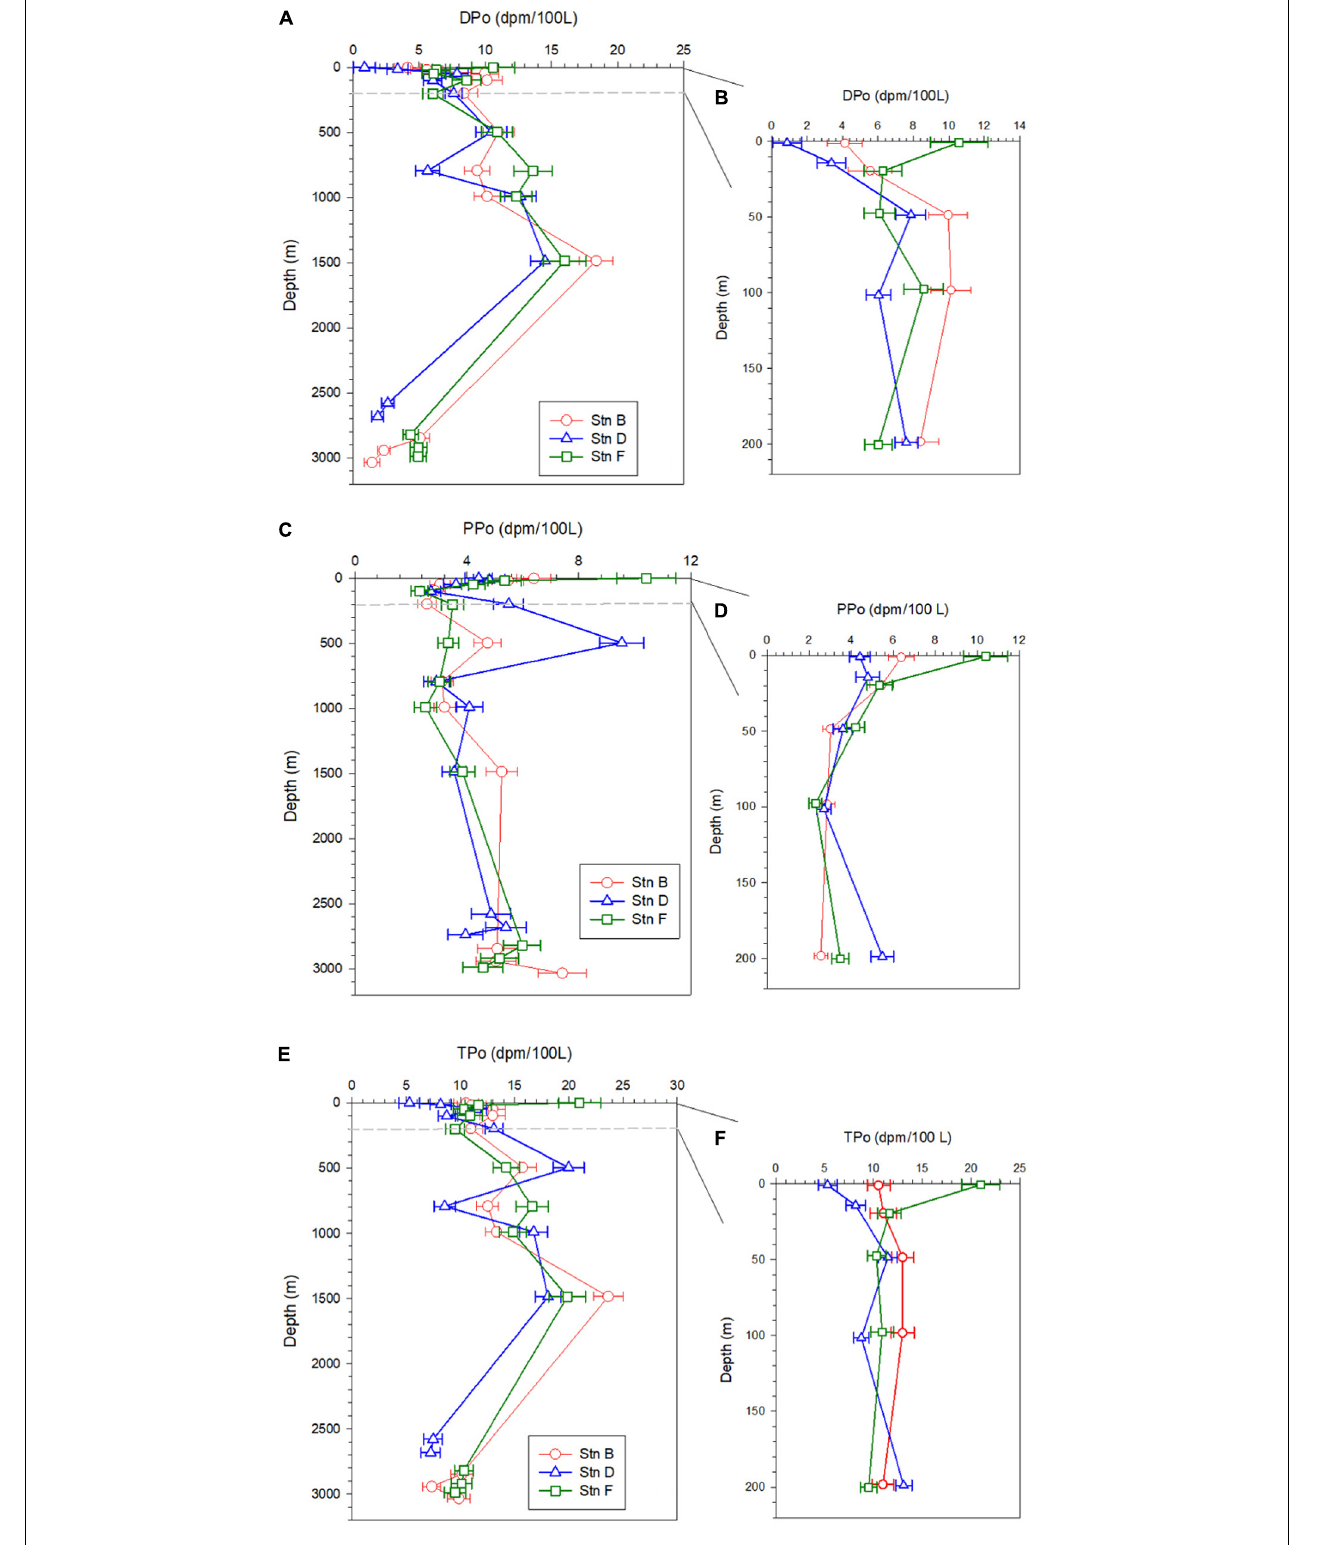
FIGURE 3 | Profiles of dissolved 210 Po (DPo), particulate 210 Po (PPo), and total 210 Po (TPo) at the three sites; panels (A,C,E) are profiles in the full water column; panels (B,D,F) are profiles in the upper 200 m.